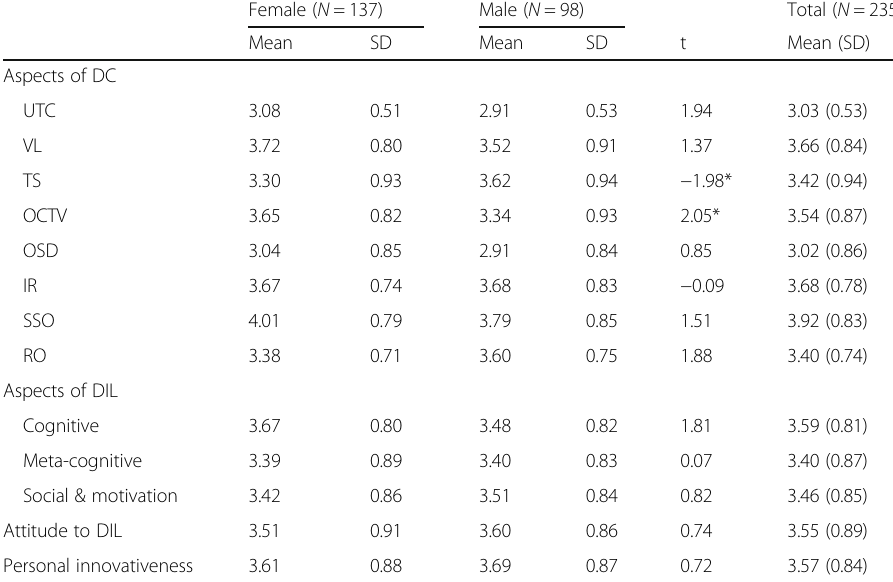
Table 6 Independent sample t-test and descriptive results of DC, DIL, Attitude to DIL and Personal